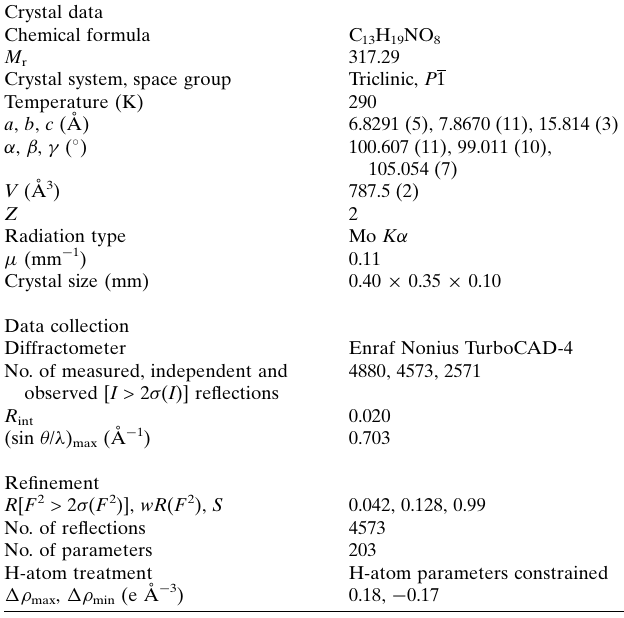
Table 5 Experimental details. Crystal data Chemical